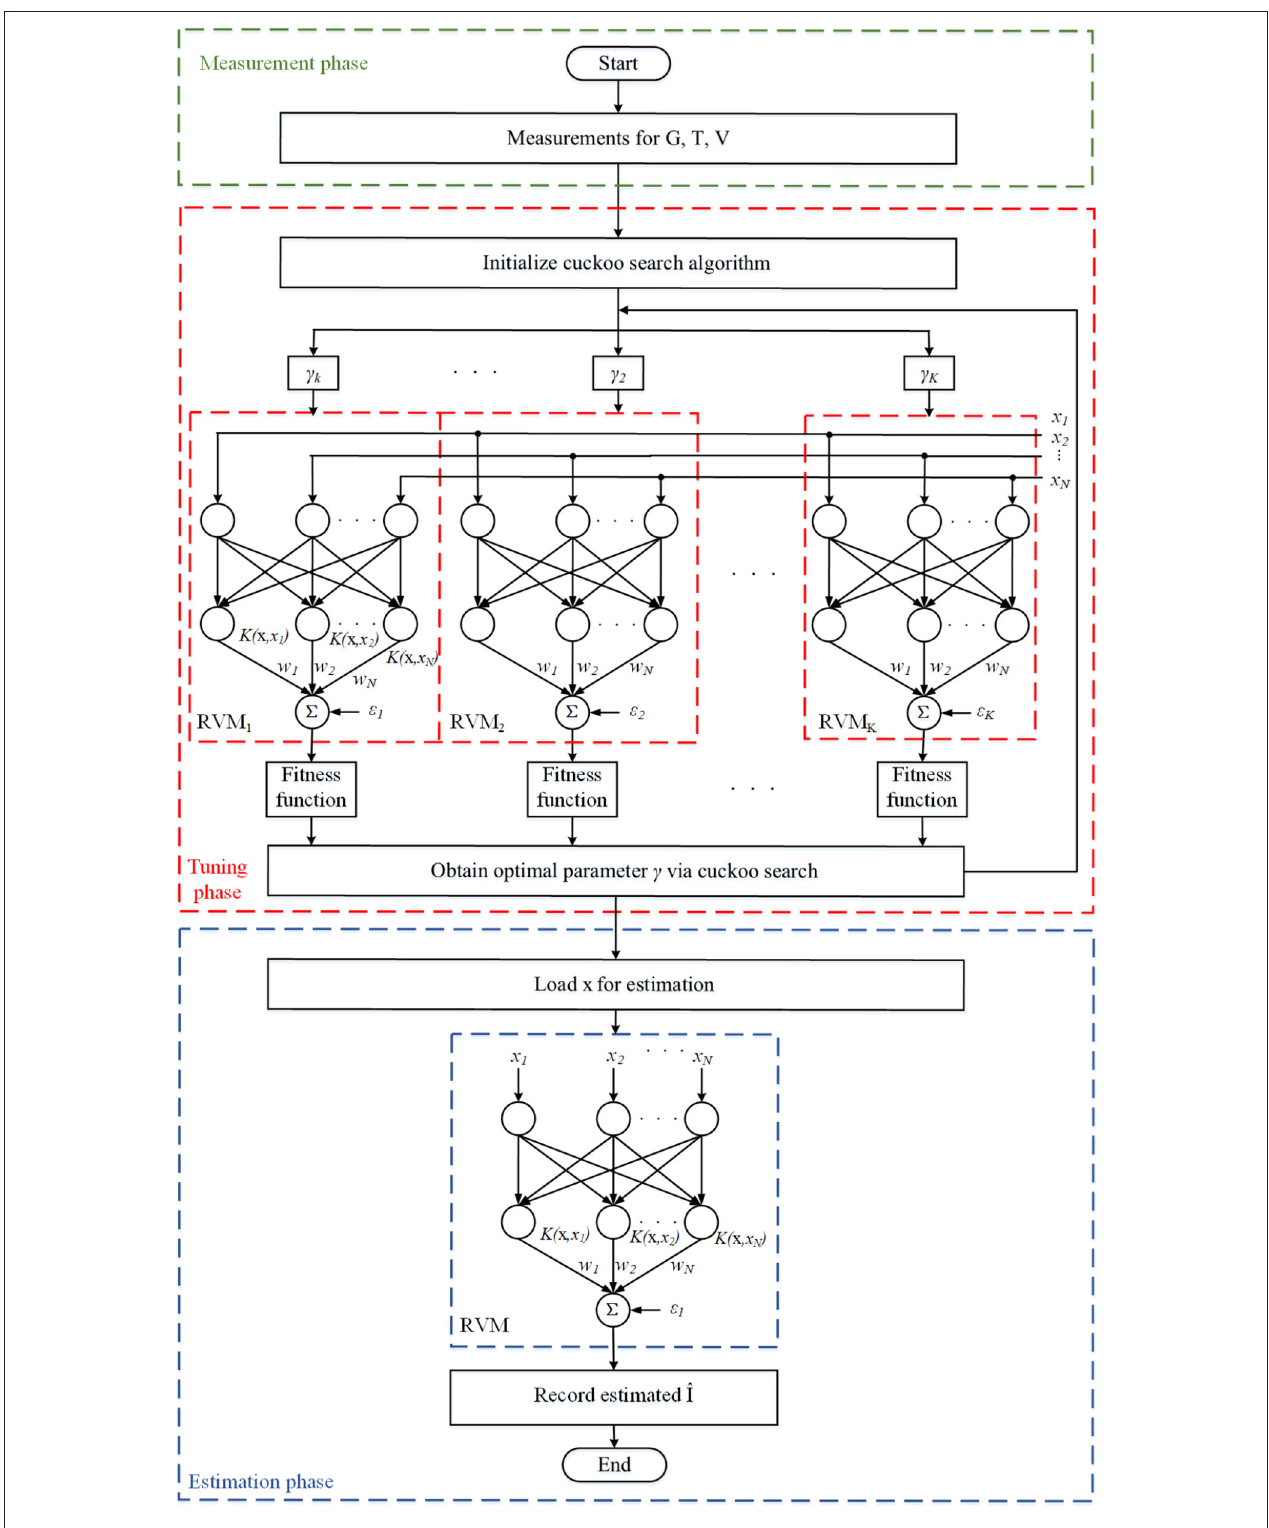
FIGURE 2 | Optimization process for RVM PV